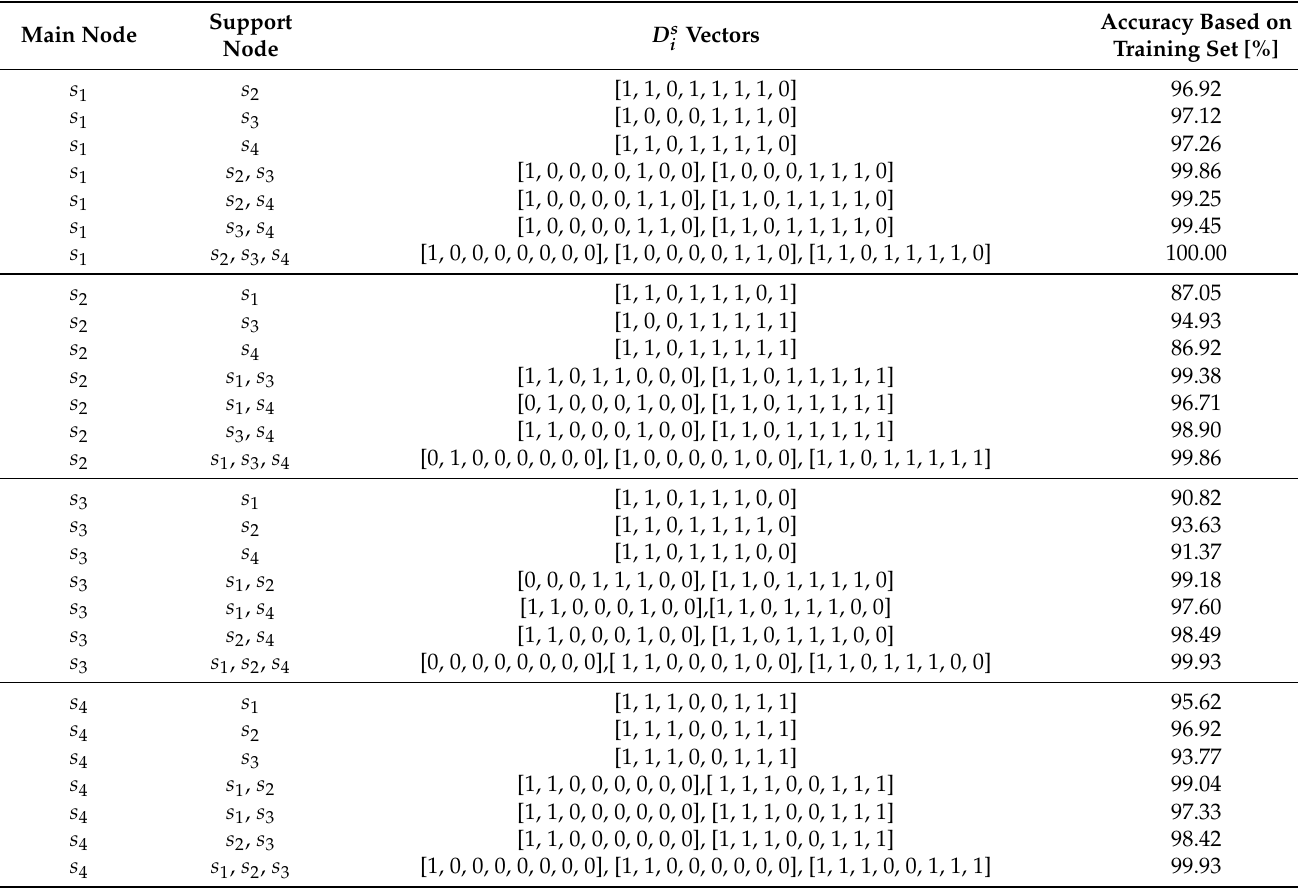
Table 1. Training accuracy obtained for the proposed method using the network with support- ing nodes.